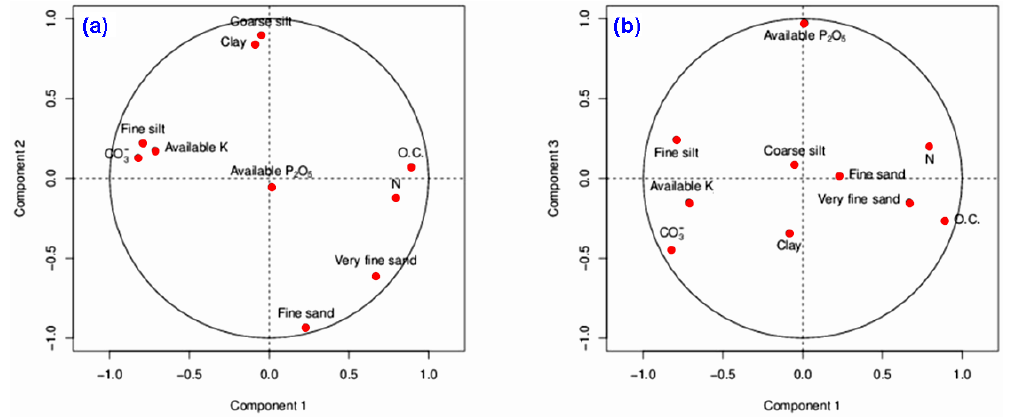
Figure 4. Plot of the correlation coefficients within a unit circle on the plane of components 1 and 2 (a) and components 1 and 3 (b) .